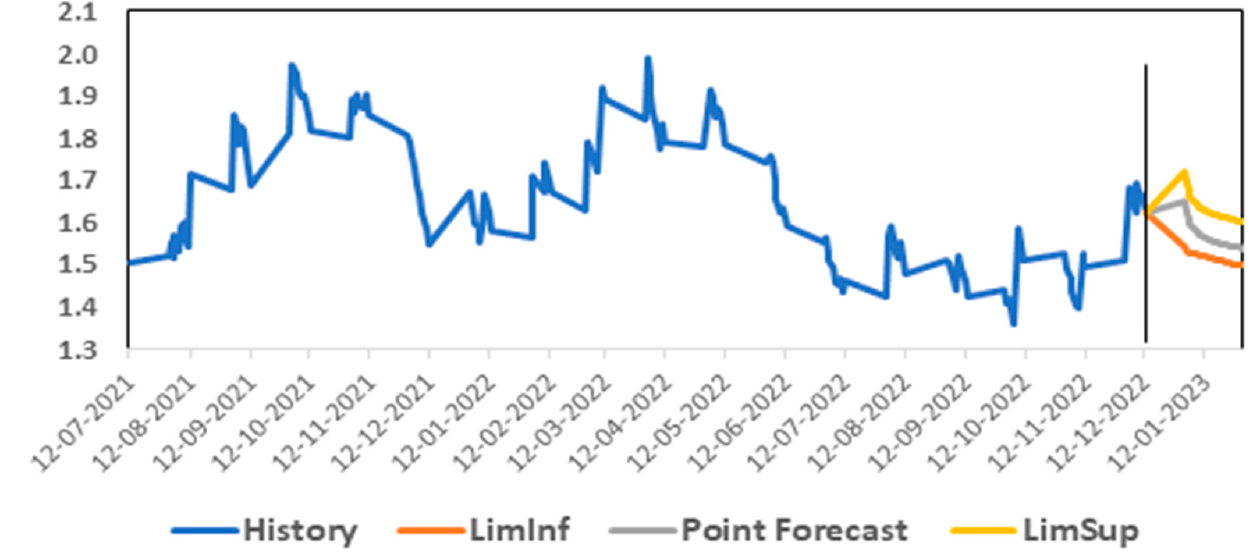
Figure 4. Out-of-Sample Forecast: Scenario 2, Volatility: Cobalt/ Confidence Intervals 95% (where LimInf and LimSup are lower and upper confidence limits).